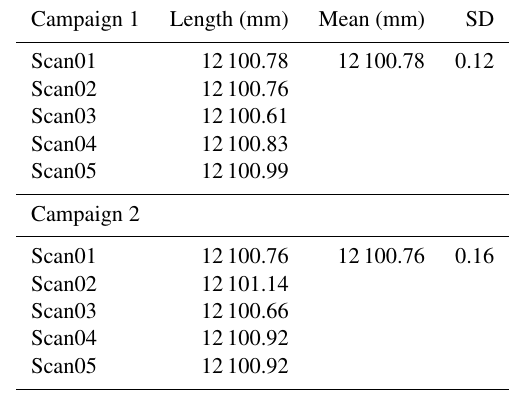
Table 2. Comparison of two campaigns.